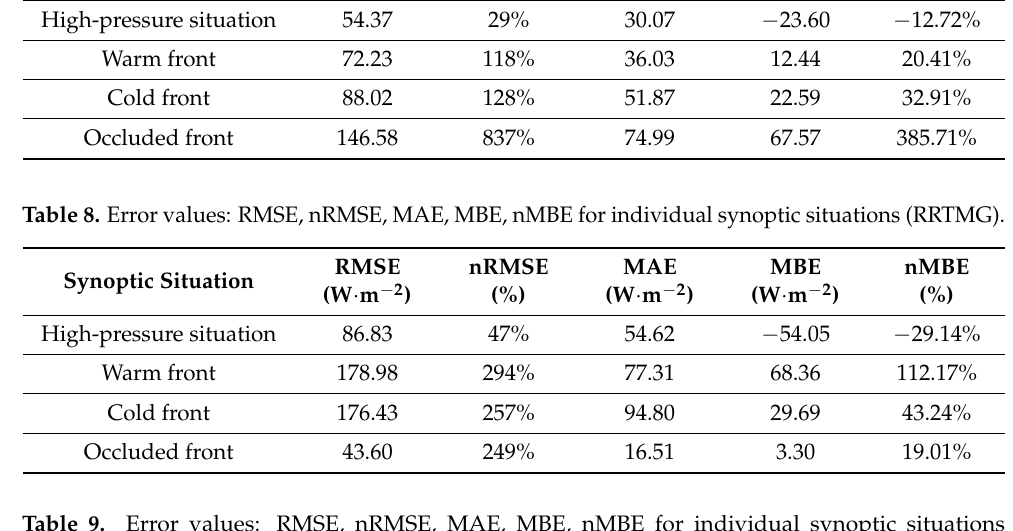
Table 9. Error values: RMSE, nRMSE, MAE, MBE, nMBE for individual synoptic situations (RRTMG(F)).